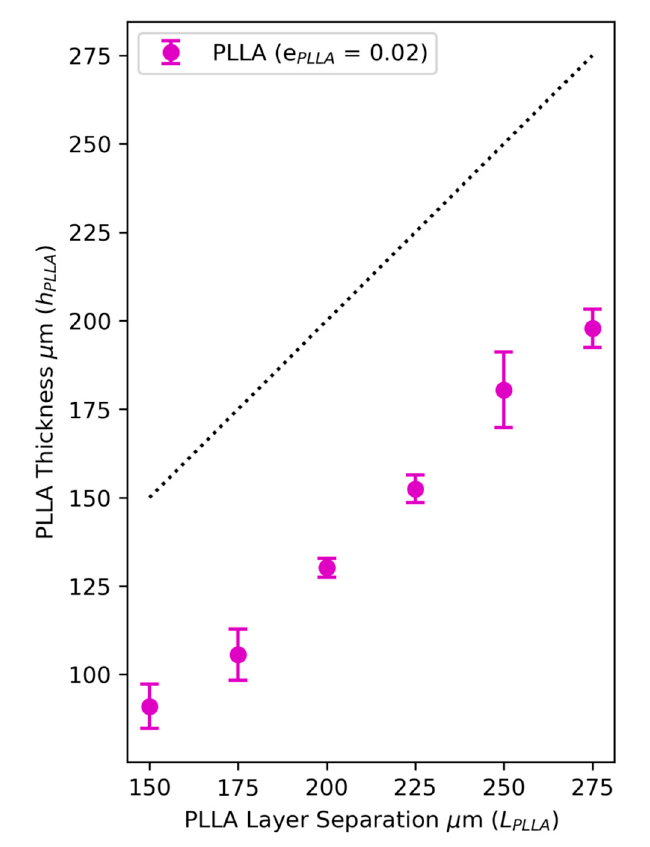
Figure 4. A plot to show the measured layer thickness of PLLA deposited directly onto the printer bed at layer separations L PLLA = 150 to 275 µm at e PLLA = 0.02. A gradient of 0.89 ± 0.03 in PLLA variation is shown, compared with a trend of one-to-one variation in thickness with layer separation (indicated by the black dotted line).